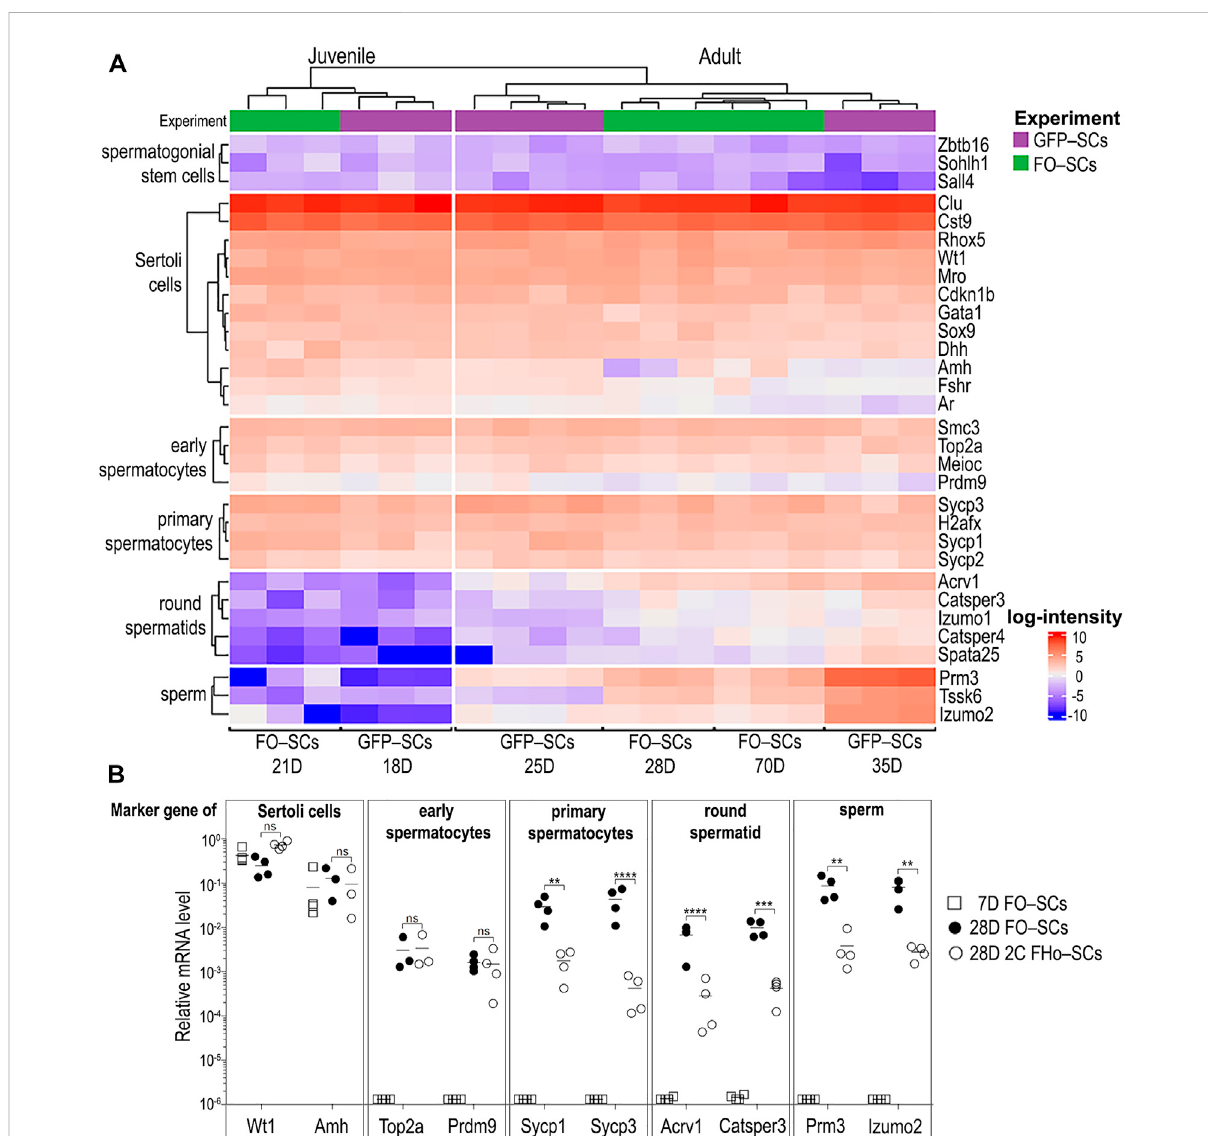
FIGURE 4 FACS-sorted SCs labelled with two surface markers exhibit the same gene expression pro fi le as GFP expressing SCs. (A) The two sorting strategies showing SC transcriptome obtained by our method is comparable to that of transgenic GFP + SCs (Zimmermann et al., 2015). In SCs, mRNAs from all types of GCs within STs was detected. (B) Selected signature genes of all ST cell types were quanti fi ed by qRT PCR in FACS-sorted FO-SCs as well as in FHo-SCs. Statistical evaluation of data was made by Unpaired t -test with the following p -values: Wt1 p = 0.8463; Amh p